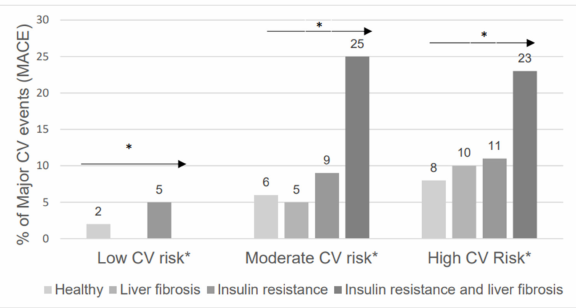
Figure 1. Major adverse cardiovascular events distribution according to liver fibrosis status and insulin resistance among CV risk subgroups. * p for trend <